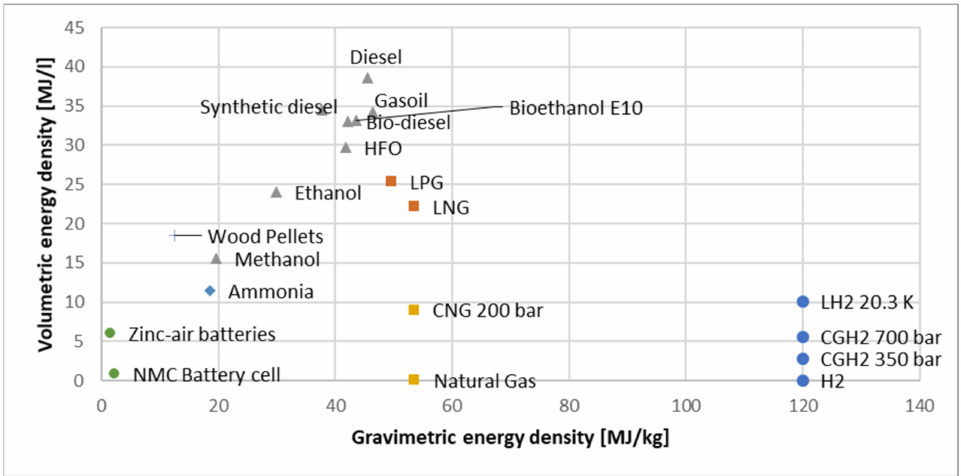
Figure 5. Energy Density of various fuels. For ships, volume is most often the critical parameter. Source for values: